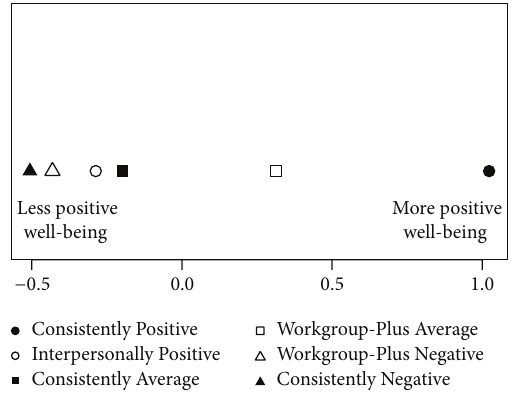
Figure 2: Sample 1 DFA group